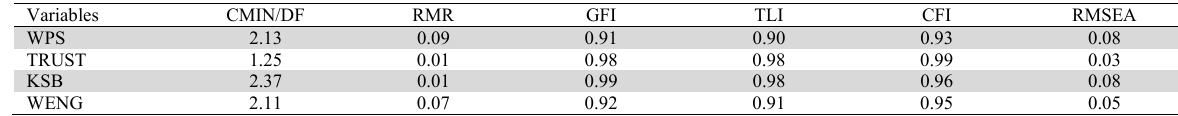
Fit indices of all variables Variables CMIN/DF